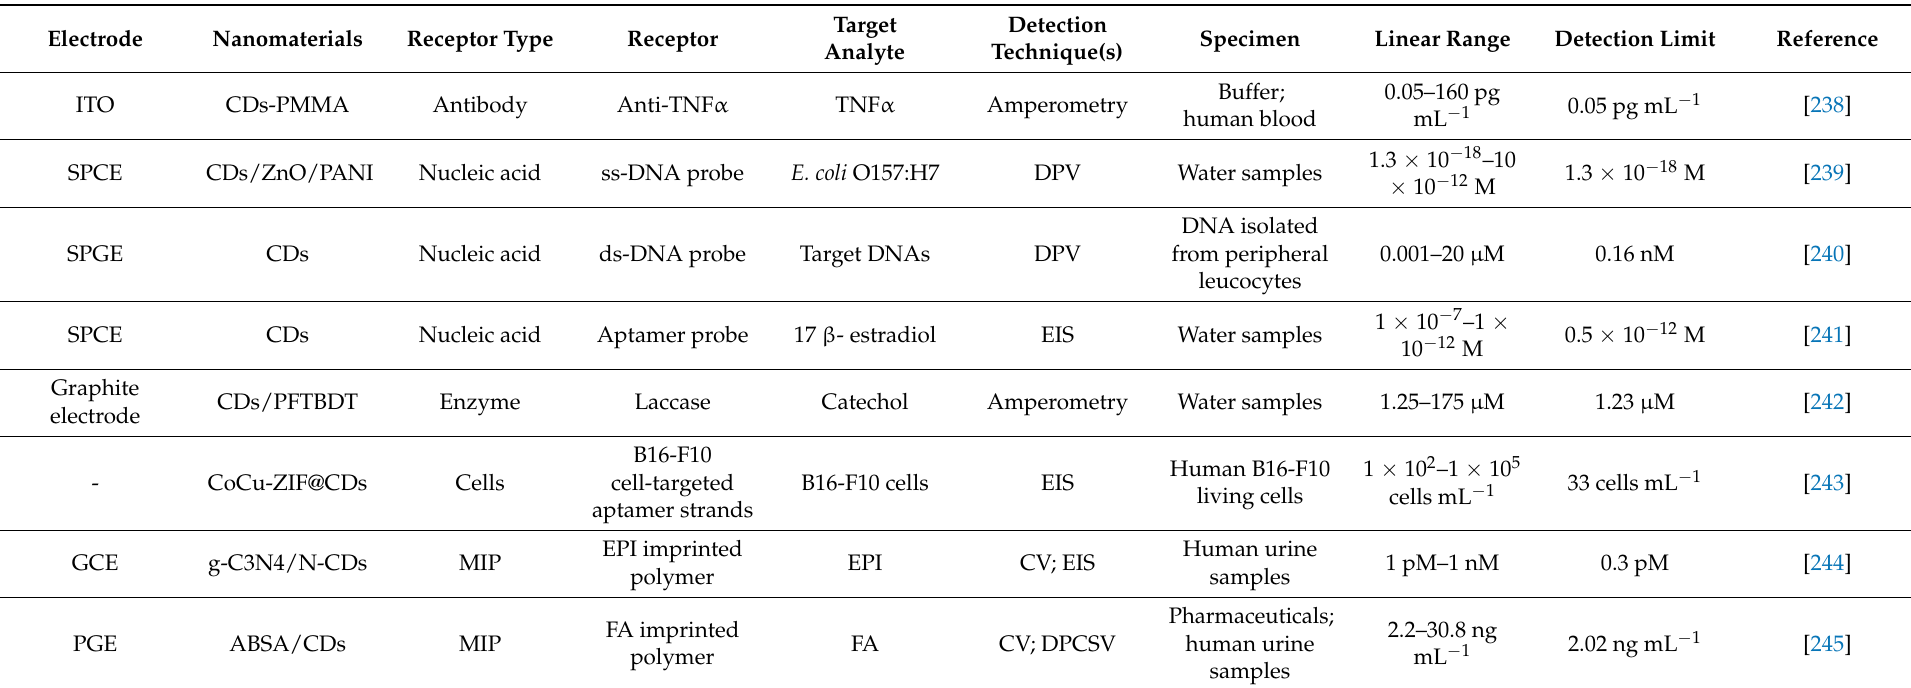
Table 1. CDs-based electrochemical biosensors reported (2018 onwards) for healthcare